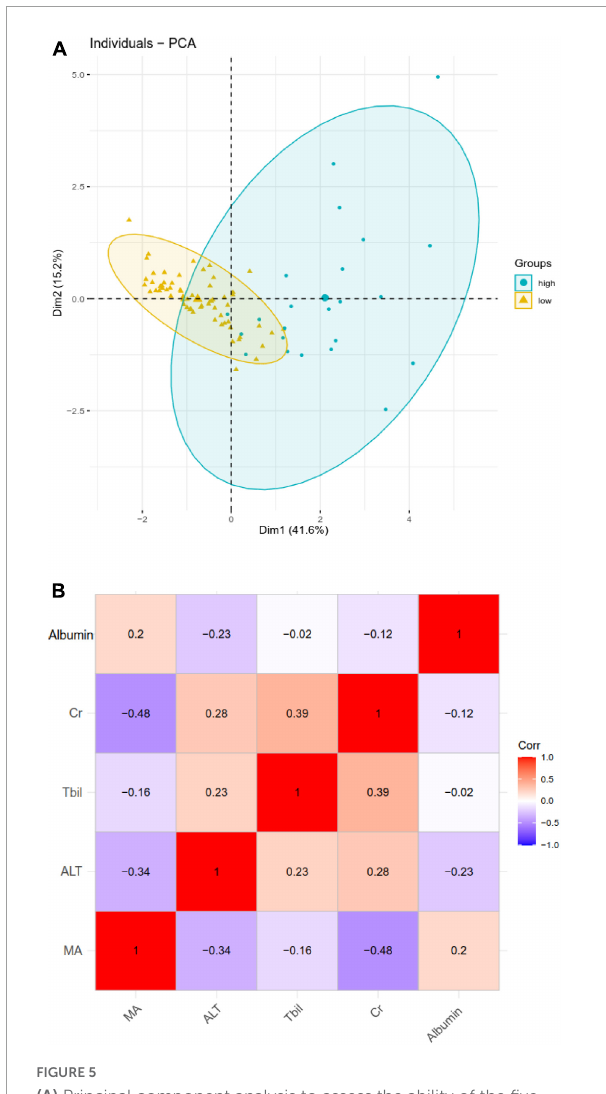
FIGURE5 (A) Principal component analysis to assess the ability of the five selected variables to differentiate heatstroke patients with or without disseminated intravascular coagulation (DIC). (B) Heatmap of pairwise correlations among the five variables. ALT,